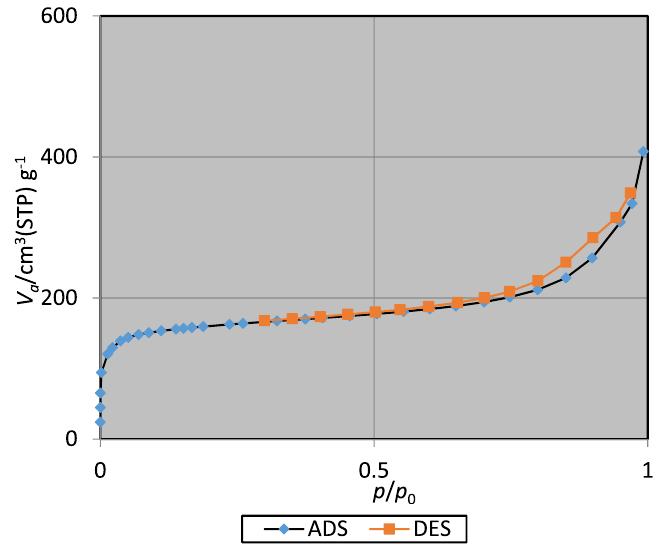
Figure 8. N 2 -adsorption isotherms of UiO-66-biguanidine/Pd.